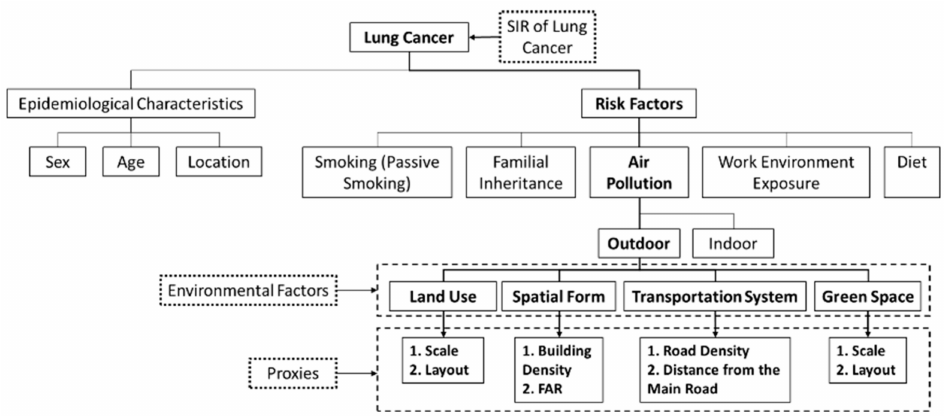
Figure 3. Risk factors of lung cancer and their